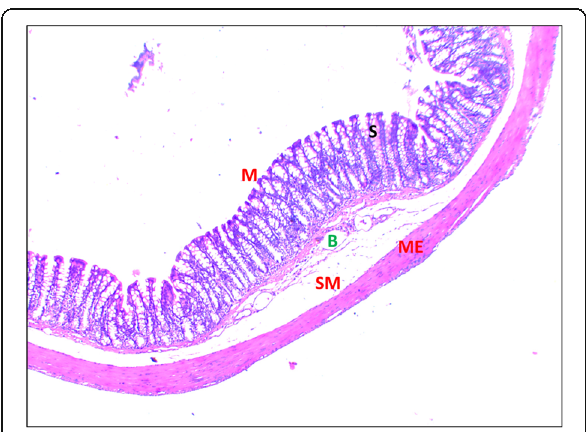
Fig. 1 Cecum section of control rat (normal structure).showing the mucosa surface (M), straight crypts (S), submucosa (SM), with blood vessels (B), and muscularis externa (ME). H&E